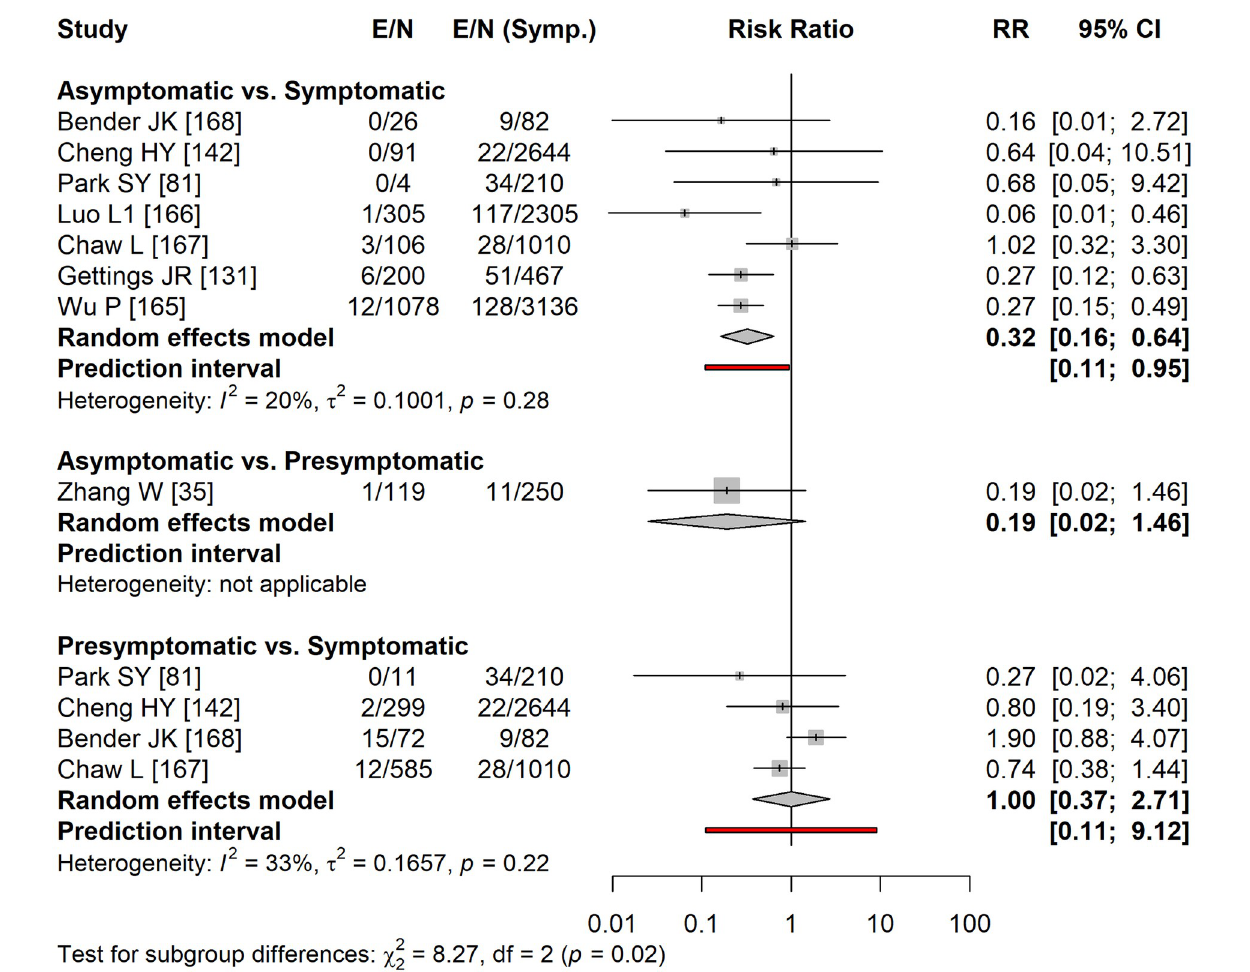
Fig 2. Forest plot of the secondary attack rate of SARS-CoV-2 infections, comparing infections in contacts of asymptomatic and presymptomatic index cases with infections in contacts of symptomatic cases. The RR is on a logarithmic scale. The diamonds show the summary estimate and its 95% CI. The red bar shows the prediction interval. CI, confidence interval; E, number of secondary transmission events; N, number of close contacts; RR, risk ratio; SARS-CoV- 2, Severe Acute Respiratory Syndrome Coronavirus 2; Symp., symptomatic individuals.